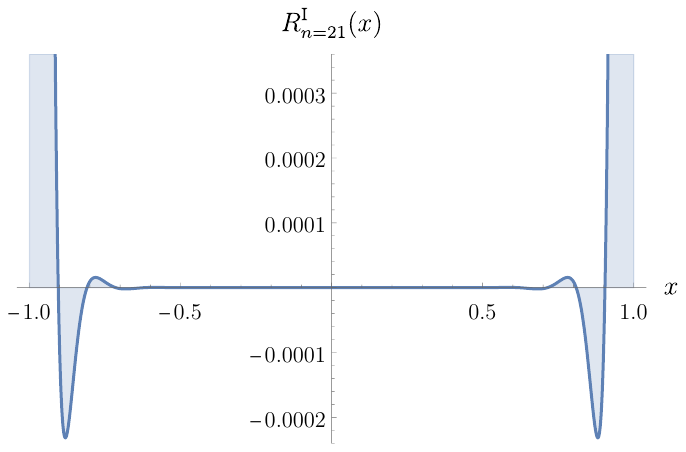
Figure 1 . The residue coefficient R I